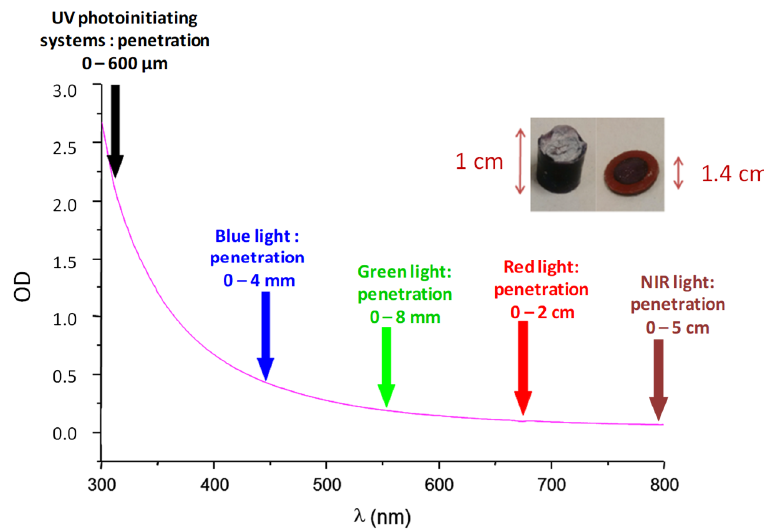
Figure 1. Light penetration inside a polystyrene latex with an average diameter of 112 nm. Inset: examples of polymerized resins containing fillers. Reproduced with permission from the authors of [21]. Copyright 2018 American Chemical Society.